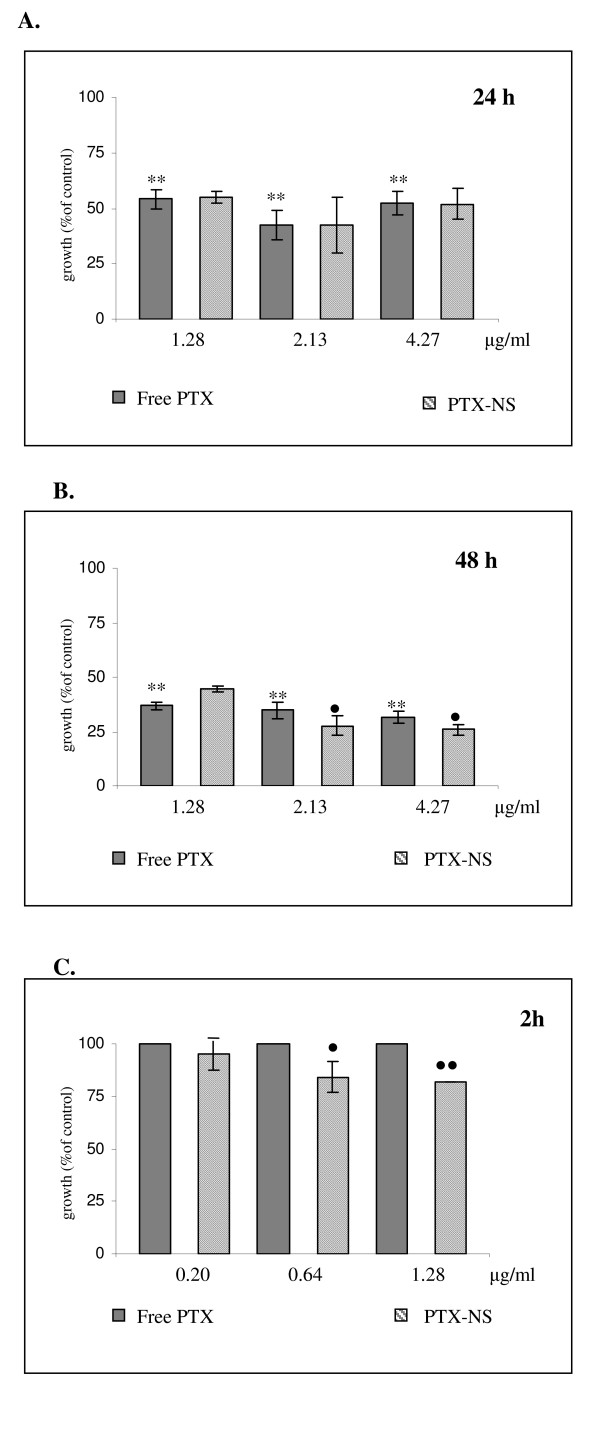
Cytotoxicity of free PTX and PTX-NS in ARO cells. ARO cells were treated with increasing concentrations (0.2 – 4.27 μg/ml) of either free or NS-loaded PTX for different times (4A = 24 h, 4B = 48 h, 4C = 2 h). Cell viability was assessed by the MTS assay. Data are expressed as % of viable cells (mean ± SD of three separate experiments, each performed in triplicate) exposed to PTX in respect to untreated controls. • free PTX vs. PTX-NS, *treated vs. not treated •*p < 0.05 ••**p < 0.01